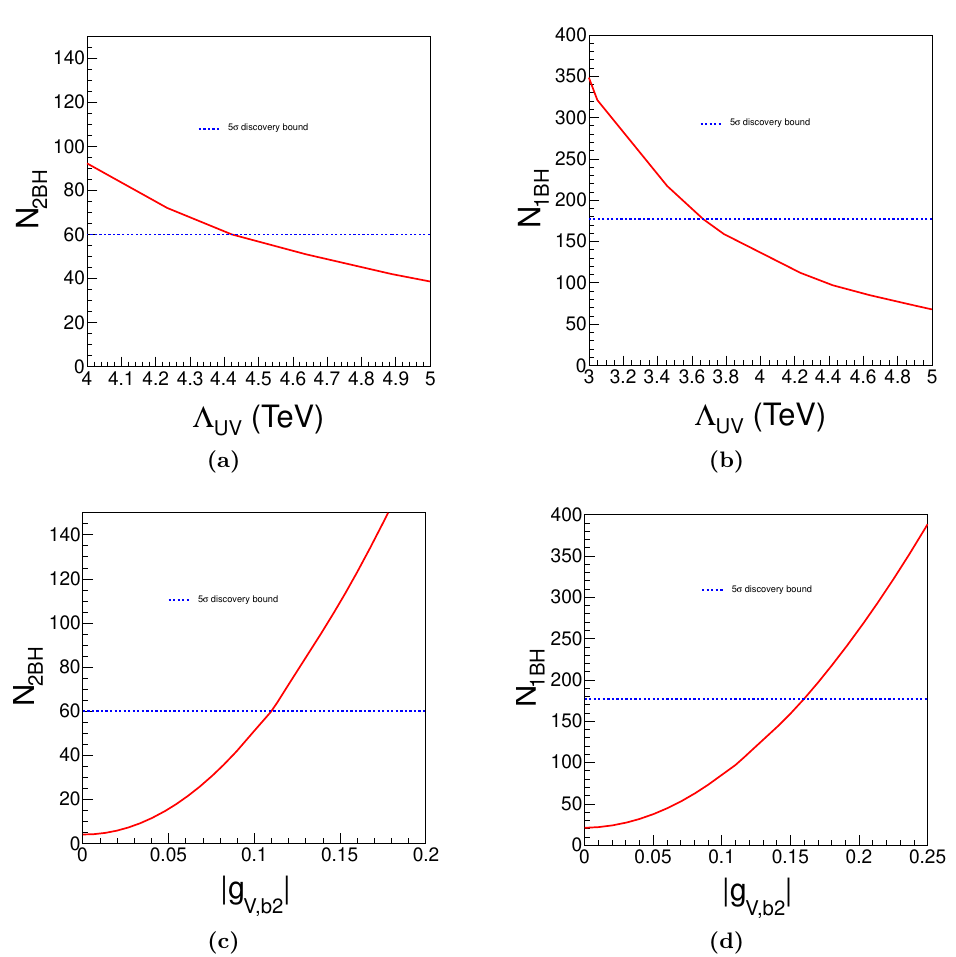
Figure 6 . The 5 σ discovery constraints on new physics cutoff at 14 TeV LHC are demonstrated. (a) is the constraint obtained from 2BH case, and (b) is the constraint obtained from 1BH case. (c) and (d) are the corresponding constraints on the g in the 2BH and 1BH case, V,b 2